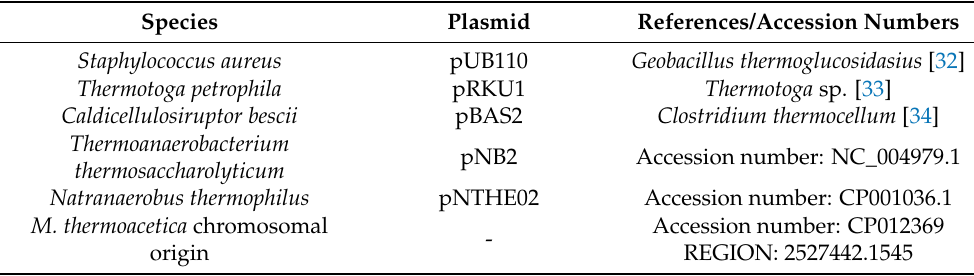
Table 5. List of candidate Gram-positive replicons tested in M. thermoacetica . The replicons were amplified from genomic DNA with the primers listed in Table 1 and cloned into pMTLK with FseI and AscI. Accession numbers are provided for replicons that have not been previously reported for